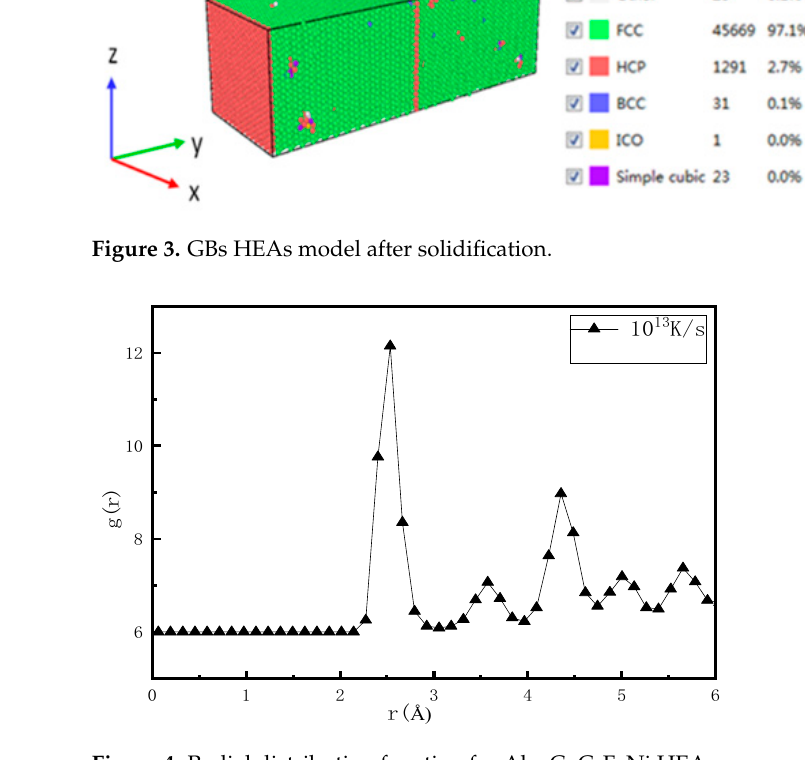
Figure 4. Radial distribution function for Al 0.1 CoCrFeNi HEAs .